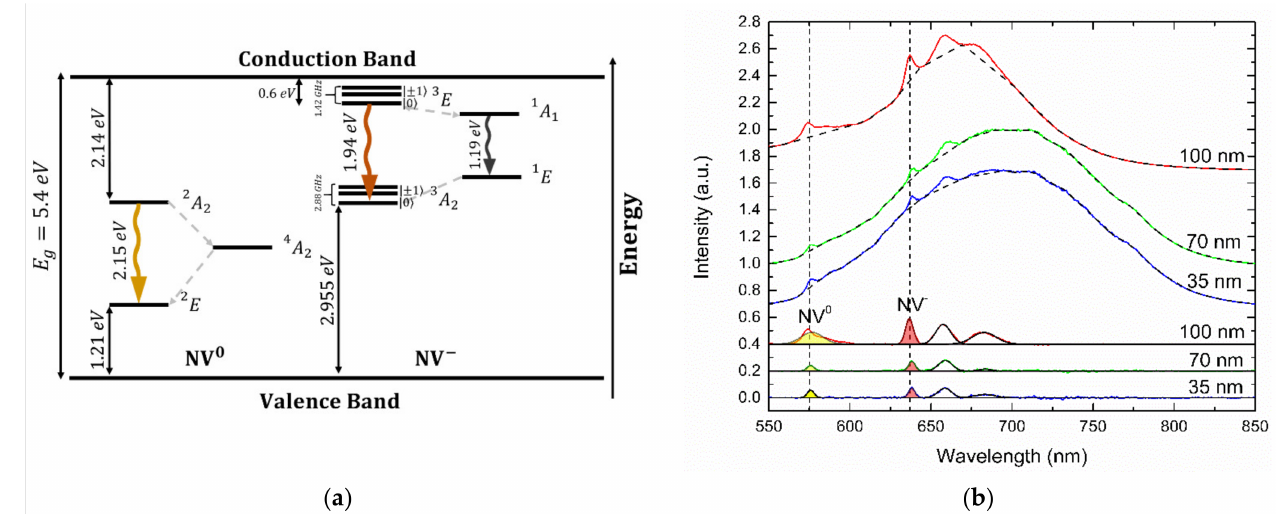
Figure 1. ( a ) Energy level diagram of the NV 0 and NV − centres in the diamond crystal lattice. The solid arrows denote the energy separation from the energy level to the valence or conduction band, and E g is the diamond’s bandgap. The dashed arrows characterize the intersystem crossing between two energy levels. The wavy coloured arrows are the observed radiative transitions. ( b ) Fluorescence spectra of HPHT nanodiamonds of different sizes recorded at 25 ◦ C. The top-coloured lines are normalized fluorescence spectra, the top dashed black lines are the baselines, the bottom-coloured lines are the filtered spectra, the bottom solid black lines are the Gaussian fits, and the bottom-coloured areas correspond to fluorescence peaks of the NV